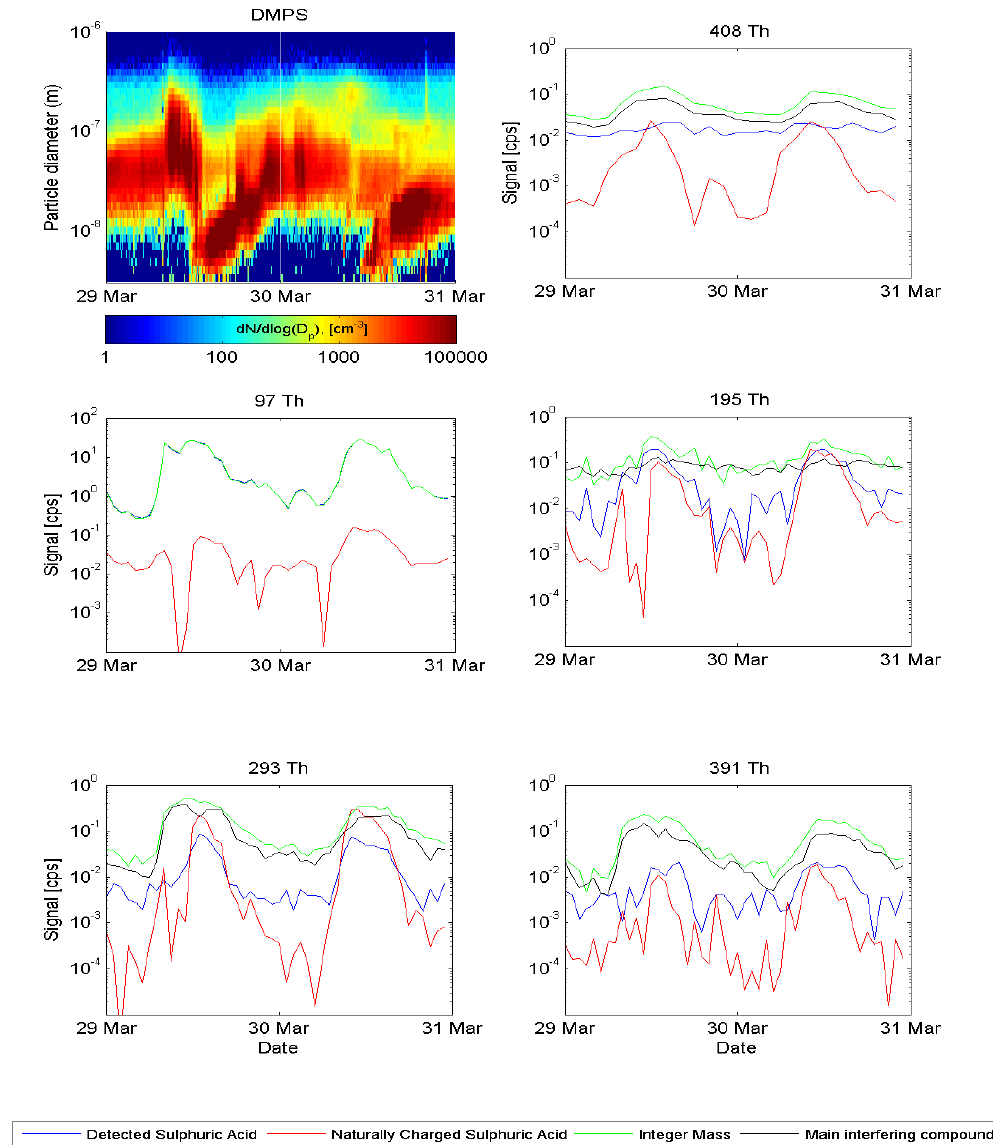
Figure 3. Particle and ion concentrations (cm -3 ) measured at Hyytiälä site on 29 and 30 March 2011. Particle size distribution measured with DMPS is shown in the upper left. Other pictures correspond to sulphuric acid monomer (97Th), dimer (195Th), trimer (293Th), tetramer (391Th) and ammonia-tetramer (408Th). In case of ammonia-tetramer, the overlapping peaks were such numerous that the reliability of the determination of the signal is most of the time questionable. The blue lines represent neutral sulphuric acid measurements using the CI-APi- TOF. The red lines represent naturally charged sulphuric acid measurements using the APi-TOF without accessory ionizing method. The green lines represent the integer mass measured with the CI-APi-TOF that includes both the sulphuric acid and the overlapping compound signals. The black lines represent the signal originating from the strongest overlapping signal at the same integer mass. Most of the CI-APi- TOF signal can clearly be explained by the sampled naturally charged